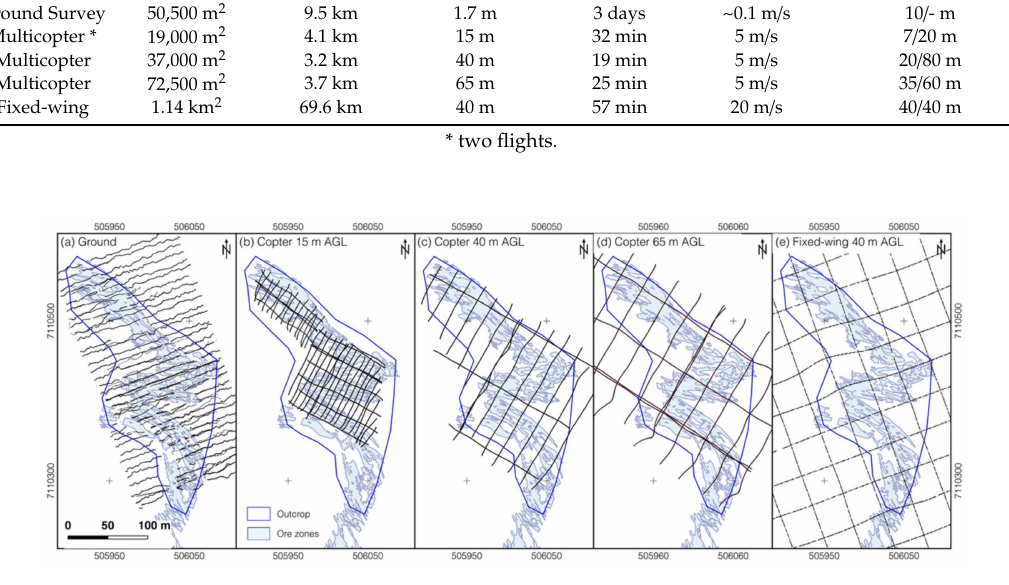
Figure 5. Acquisition patterns of the di ff erent magnetic surveys across the mapped ore zones (light blue polygons) in the Metsämalmi outcrop (flight lines are shown as dark blue lines): ( a ) ground survey; ( b ) 15 m multicopter; ( c ) 40 m multicopter; ( d ) 65 m multicopter; ( e ) 40 m fixed-wing